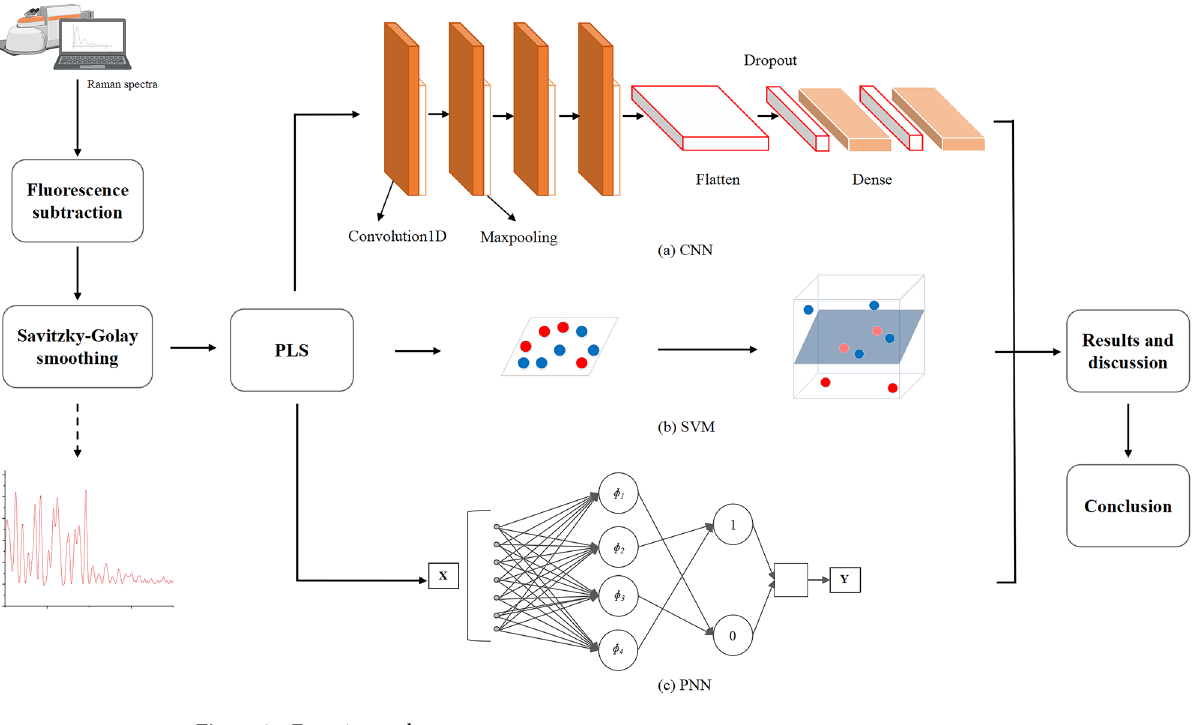
Figure 2. Experimental process.